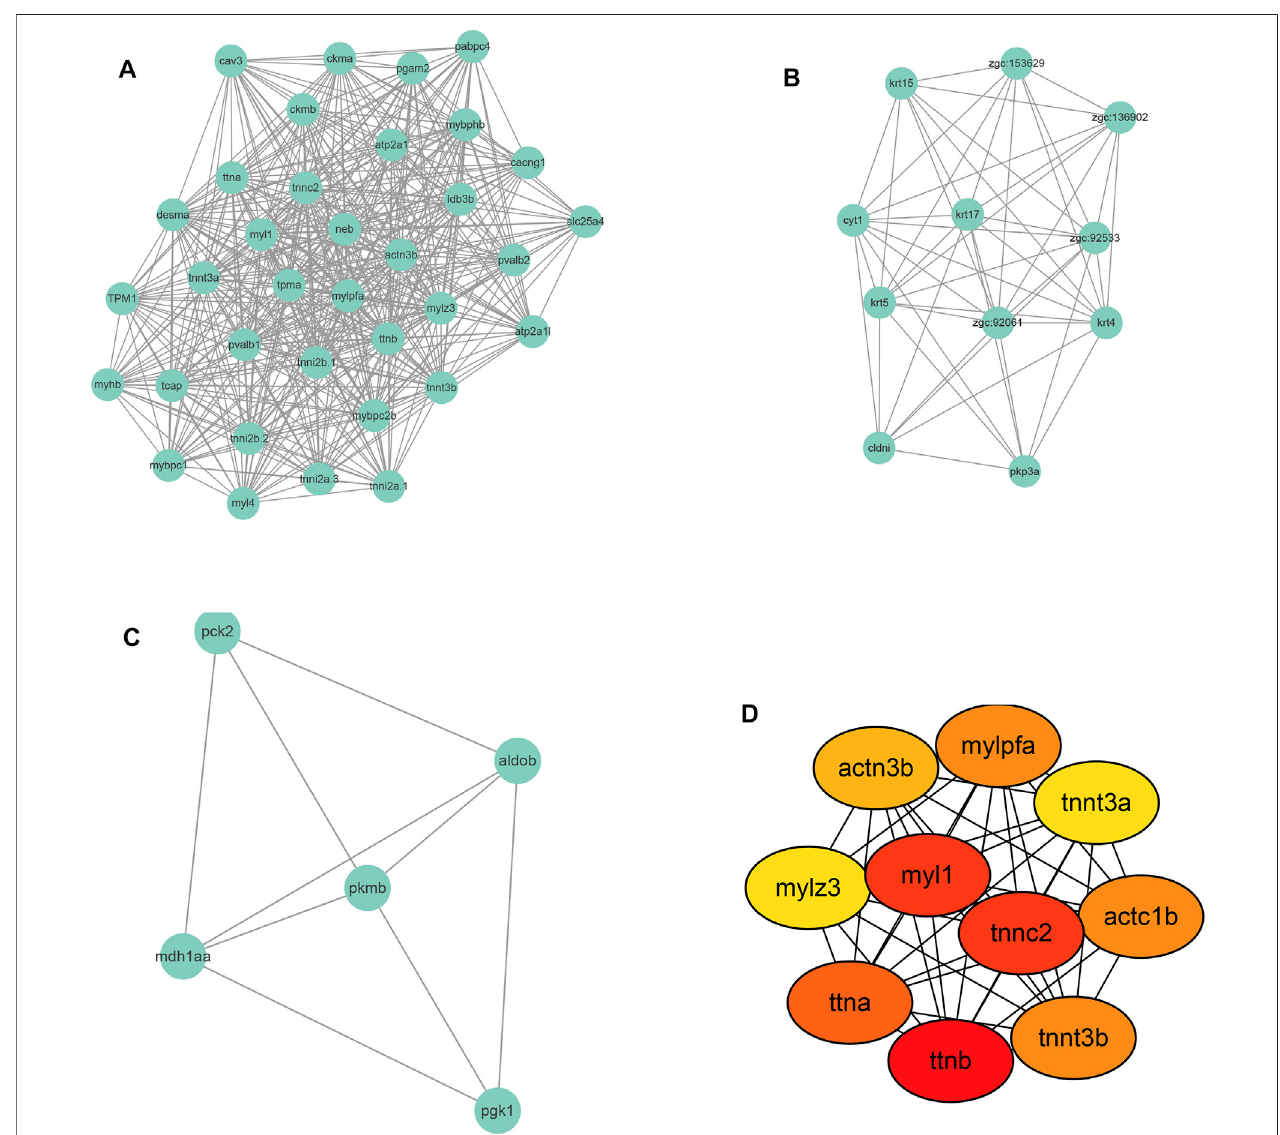
FIGURE 6 | Module screening (A – C) and hub gene screening (D) from Protein-protein interaction network.